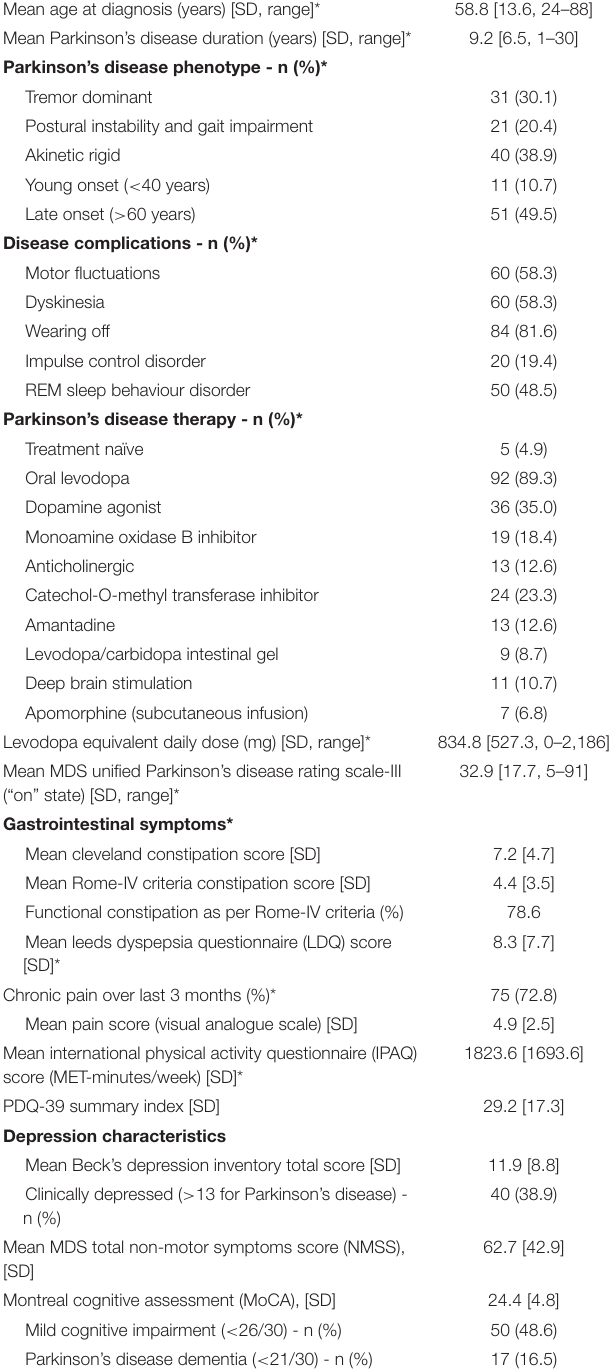
TABLE 2 | Parkinson’s disease clinical